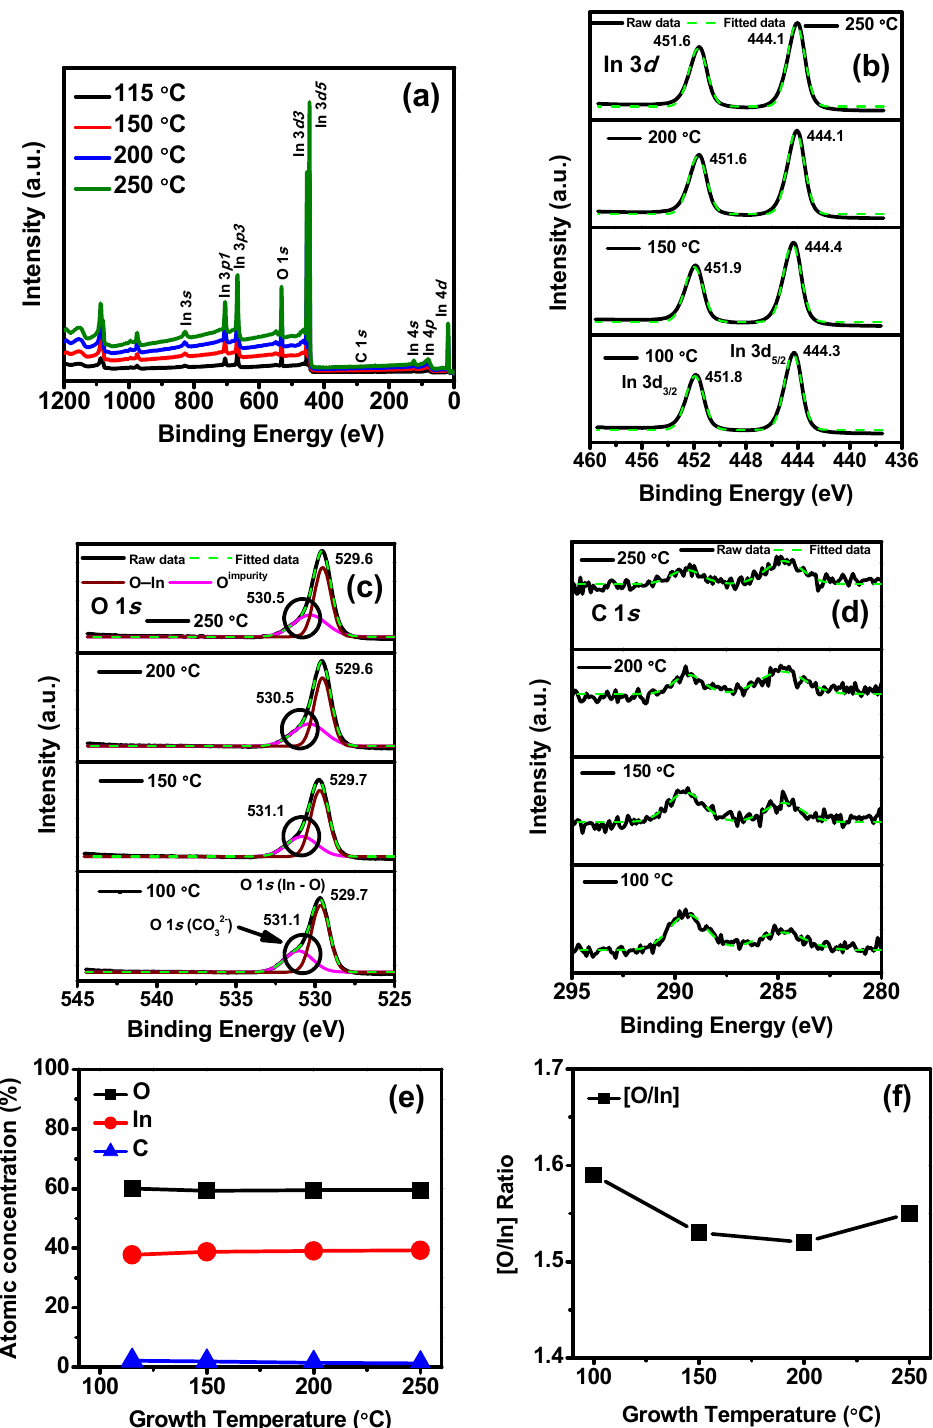
Figure 5. ( a ) Full survey XPS spectra of ALD prepared In 2 O 3 films grown at 115 °C, 150 °C, 200 °C, and 250 °C; high-resolution XPS spectra of ( b ) In 3 d core level, ( c ) O 1 s core level, ( d ) C 1 s core level, and ( e ) XPS elemental depth profiles (at.%). ( f ) [O/In] ratio of In 2 O 3 films grown at 115 °C–250 °C.